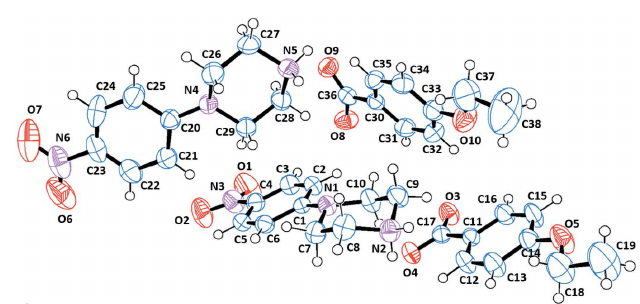
Figure 6 The independent components of compound (VI) showing the atom- labelling scheme Displacement ellipsoids are drawn at the 50% probability